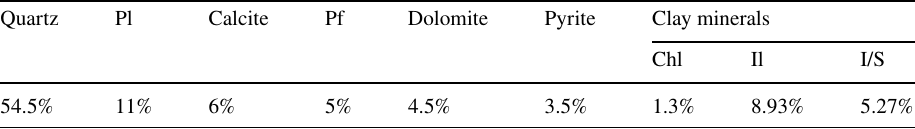
Pl is plagioclase, Pf is potash feldspar; Chl is chlorite; Il is illite; I/S is